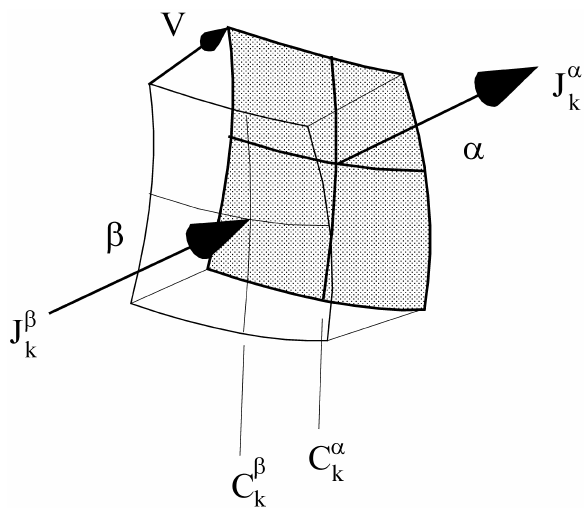
Figure 10. Illustration of the factors involved in the interface accommo- dation equation that describes the velocity v of a phase of the boundary between two